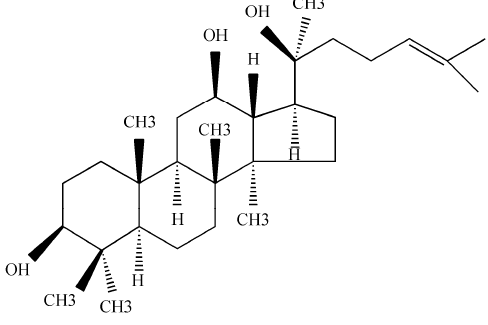
Figure 1. Structure of 20( S )-protopanaxadiol (PPD).